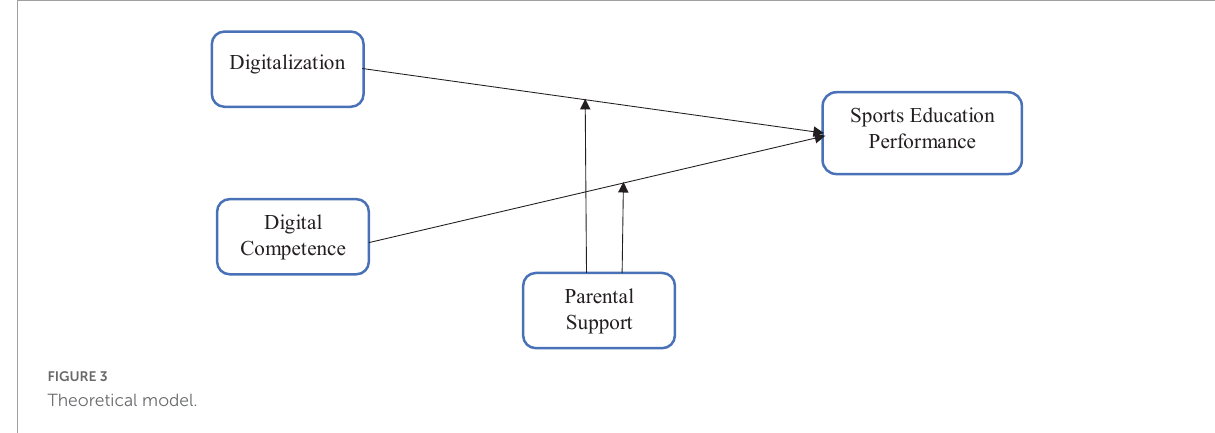
FIGURE3 Theoretical model.